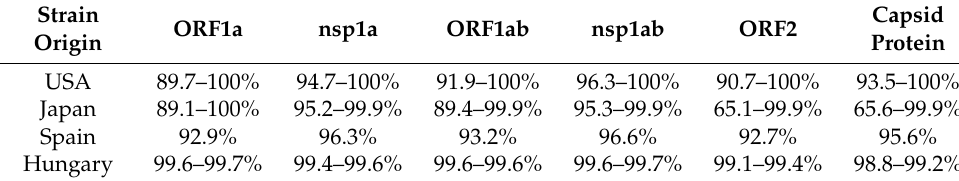
Table 2. Range of nucleotide and amino acid percent identity of PoAstV3